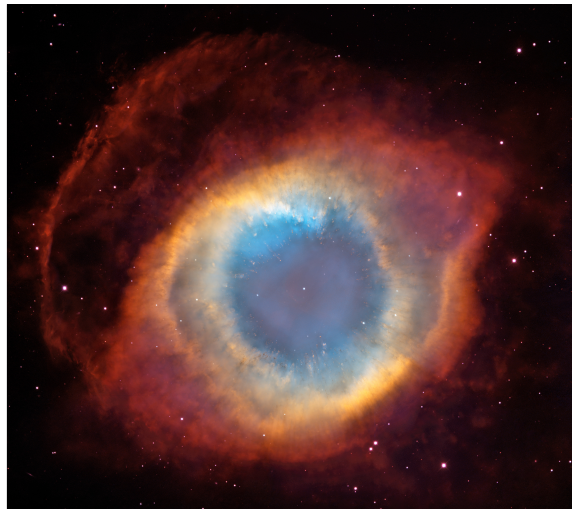
Figure 1. A composite image of the Helix nebula obtained using the HST and the Cerro Tololo Inter- American Observatory in Chile. H α +[N II ] ( λλ 6548.1,6583.4Å), emission is shown in red, an average of H α +[N II ] and [O III ] ( λλ 4958.9,5006.8Å) is shown in green, and forbidden [O III ] emission is shown in blue [5]. The nebula lies at a distance of about 200 pc, and the size of the semi-major axis is approximately 5.5 arc minutes or 66,000 AU [5]. The central star has an effective temperature of 104,000K, L ≈ 80 L (cid:12) , and R ≈ 0.028 R (cid:12) [6]. Using the semi-major axis as a representative size scale, the dilution factor (0.25 ( r / R ∗ ) 2 ) is of order 10 − 18 . Detailed insights into the structure and morphology of the Helix nebula can be found in many works (e.g., [5,7]). Image credit: NASA,